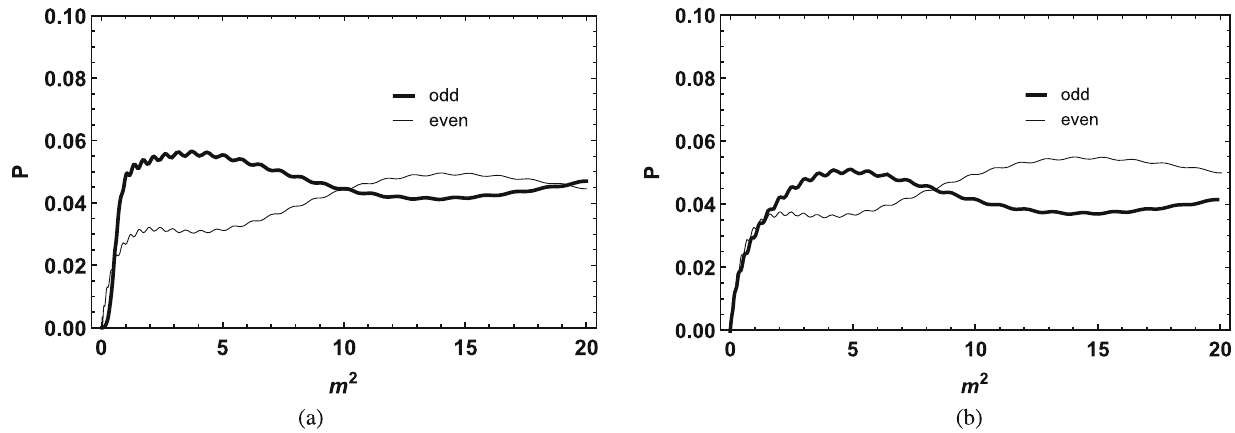
Fig. 15 The behavior of the relative probability P ( m ) for G 1 ( T ) with n = 2, k = − 0 . 06 and p = λ = 1. a Gauge field. b KR field